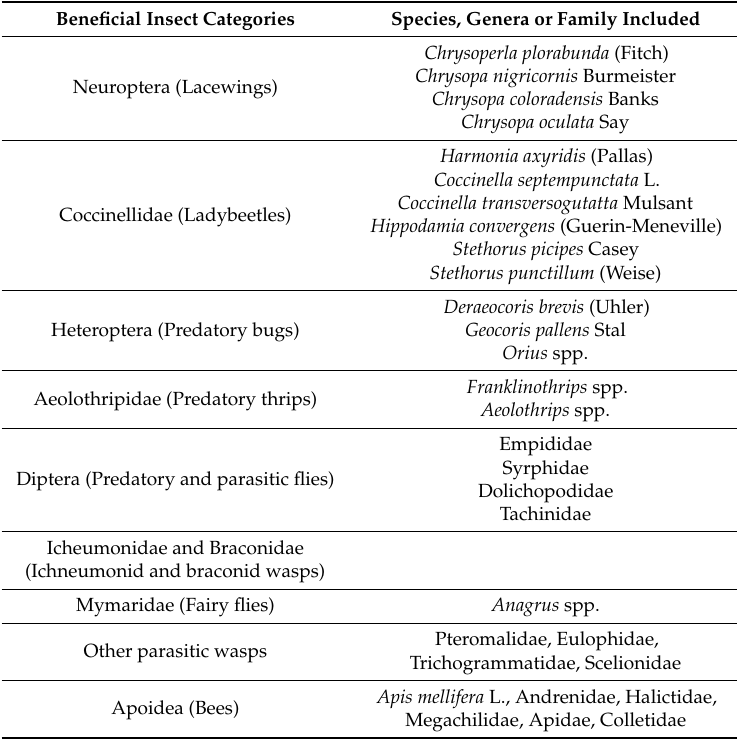
Table 1. Categories of beneficial insects identified and recorded in this study, along with species, genera and families within each category.